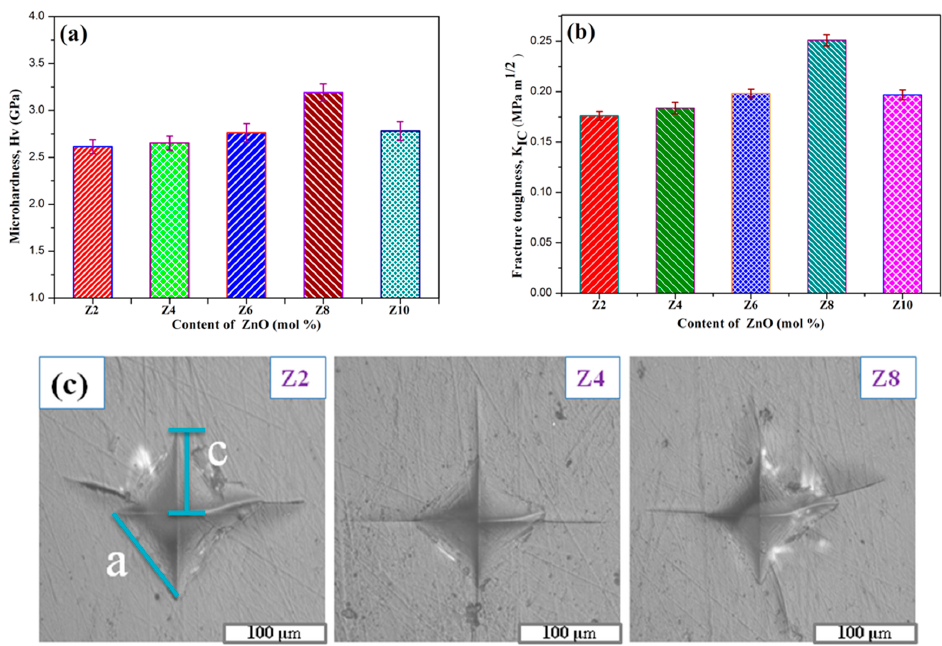
Figure 3. ( a ) Microhardness and ( b ) fracture toughness of the Z2, Z4, Z6, Z8 and Z10 glasses as a